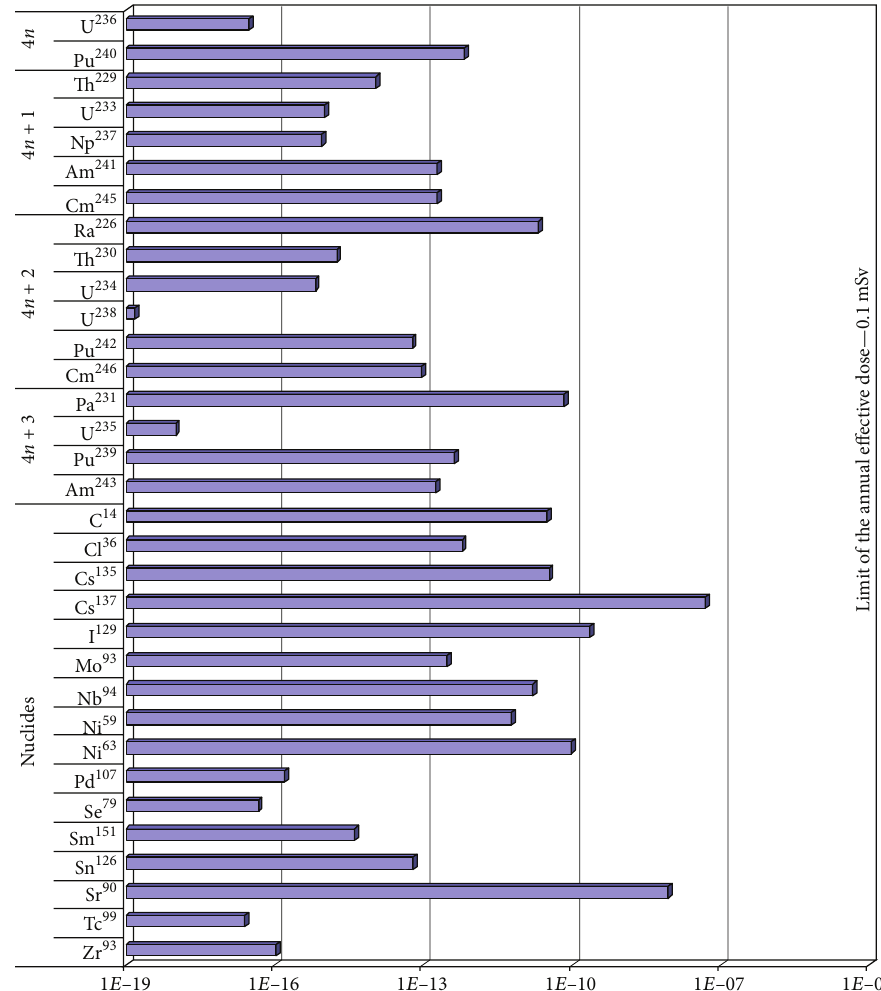
Figure 13: Maximum dose rate to an exposed member of public by ingestion of water with radionuclides considered in this study in Sv/a.